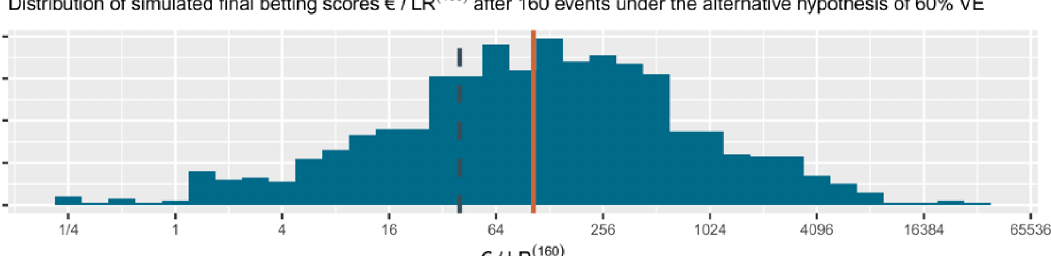
Figure 4. (and Figure 5 ) 1000 simulated sequences of betting scores by round in the FDA game after 160 events assuming a probability of 0.29 (40 / 140) for each event to occur in the vaccine group. This is the alternative hypothesis of 60% vaccine efficacy (VE) used to power the CureVac AG (2020) trial at a number of events of 160. The dashed line is the threshold 1 /α = 40 one-sided and the solid line is the implied target of €104. Note that the x-axis is on a log scale.